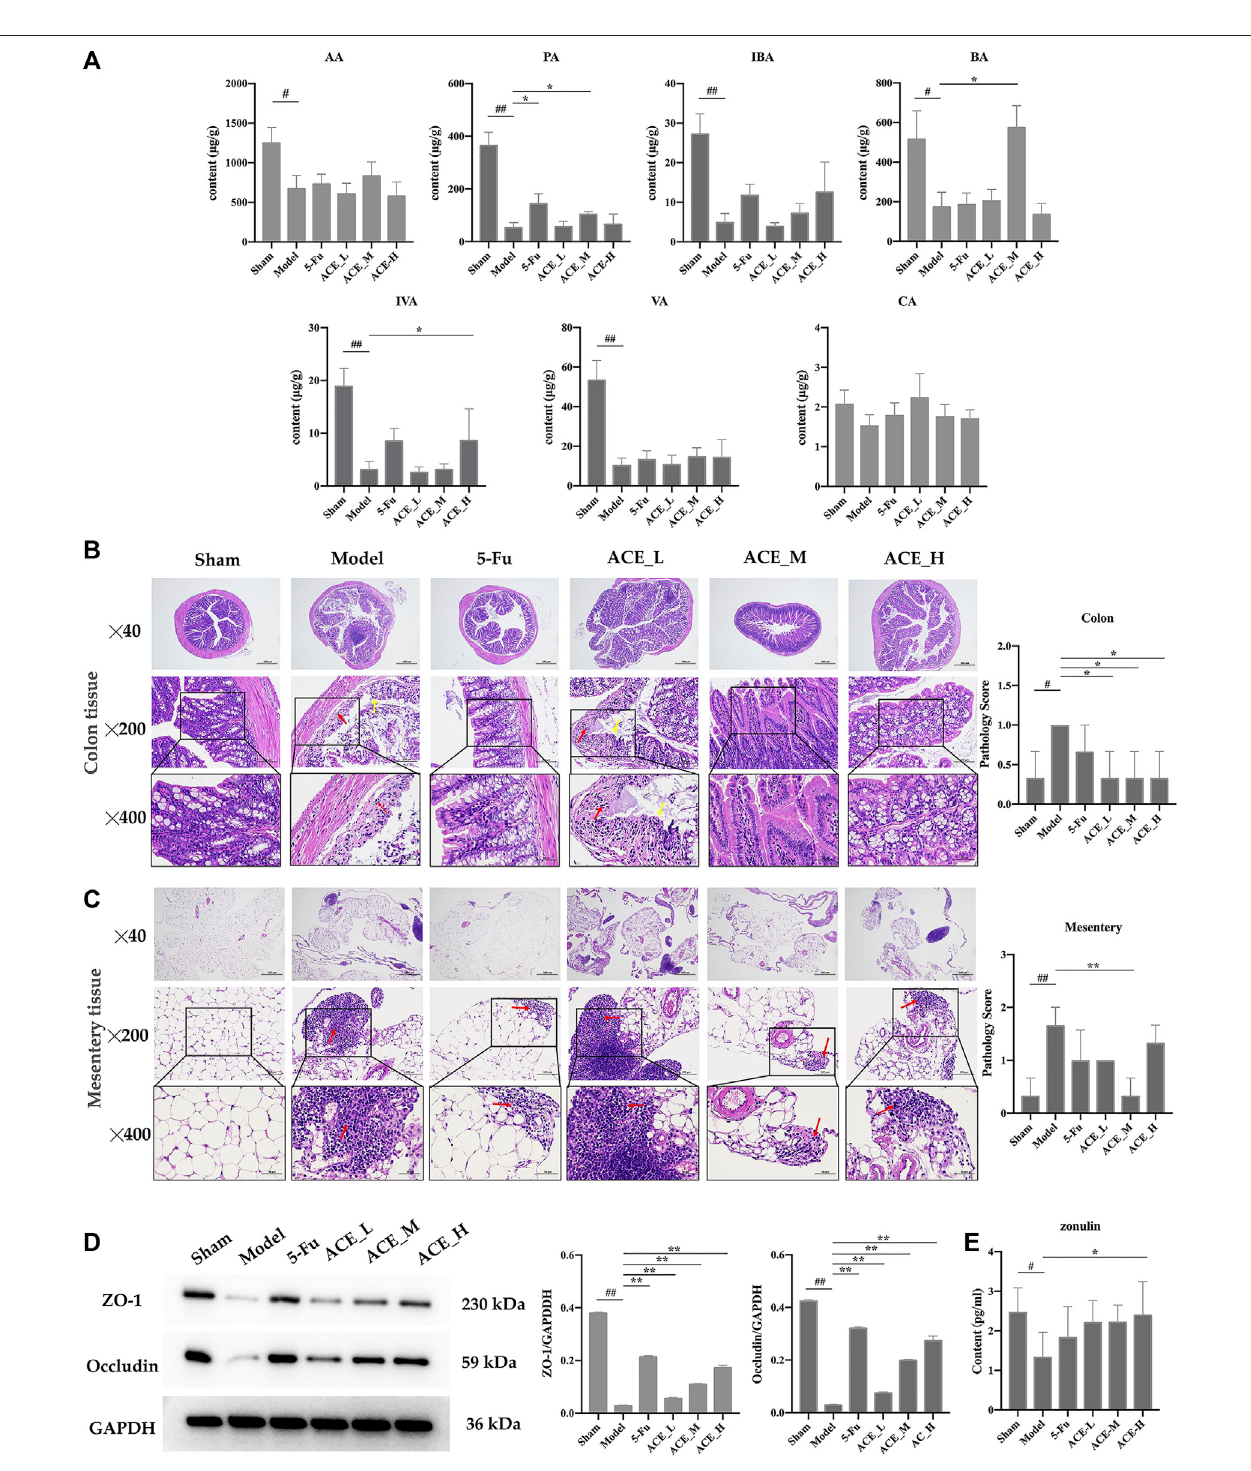
FIGURE 5 | The effect of Astragalus mongholicus Bunge- Curcuma aromatica Salisb. extract on SCFAs and the intestinal barrier of colon cancer-bearing mice. (A) The contents of short-chain fatty acids in stool specimens after ACE administration. (B) Colon tissue histopathological changes (haematoxylin and eosin (HE) stain), disappearance of the mucosal layer (yellow arrows), and in fl ammatory cell in fi ltration (red arrows). (C) Conjunctival tissue histopathological changes (haematoxylin and eosin (HE) stain) and in fl ammatory cell in fi ltration (red arrows). (D) Expression of tight junction proteins (ZO-1 and Occludin) detected by WB. (E) The content of zonulin in serum detected by ELISA. # p < 0.05 and ## p < 0.01, compared with the sham group; * p < 0.05 and ** p < 0.01, compared with the model group. n (cid:2) 10.